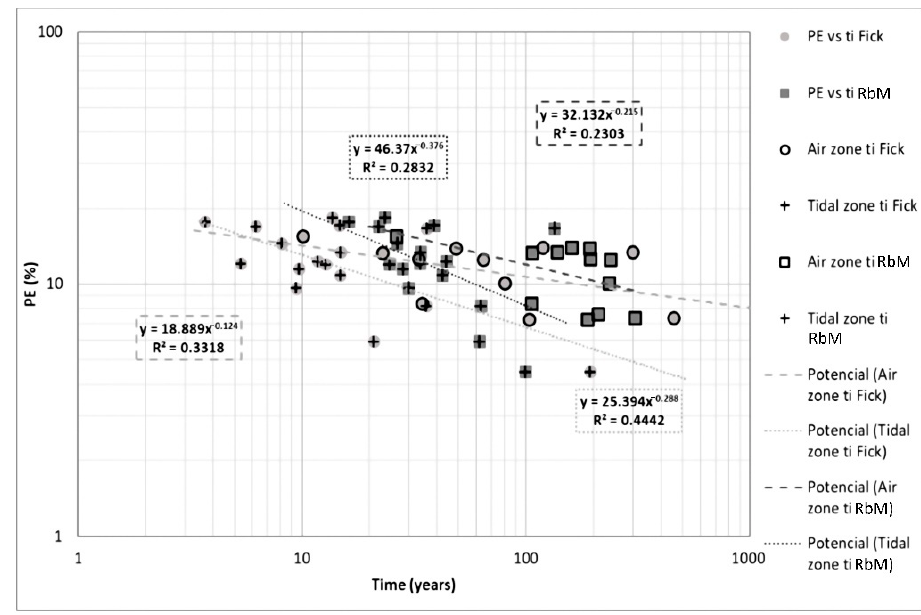
Figure 12. EP vs. t i in both zones and models.